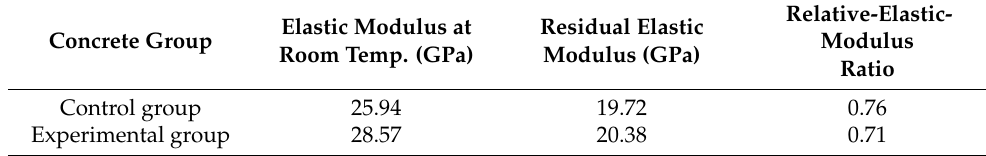
Table 13. Relative-elastic-modulus ratio of the concrete after exposure to high temperatures.